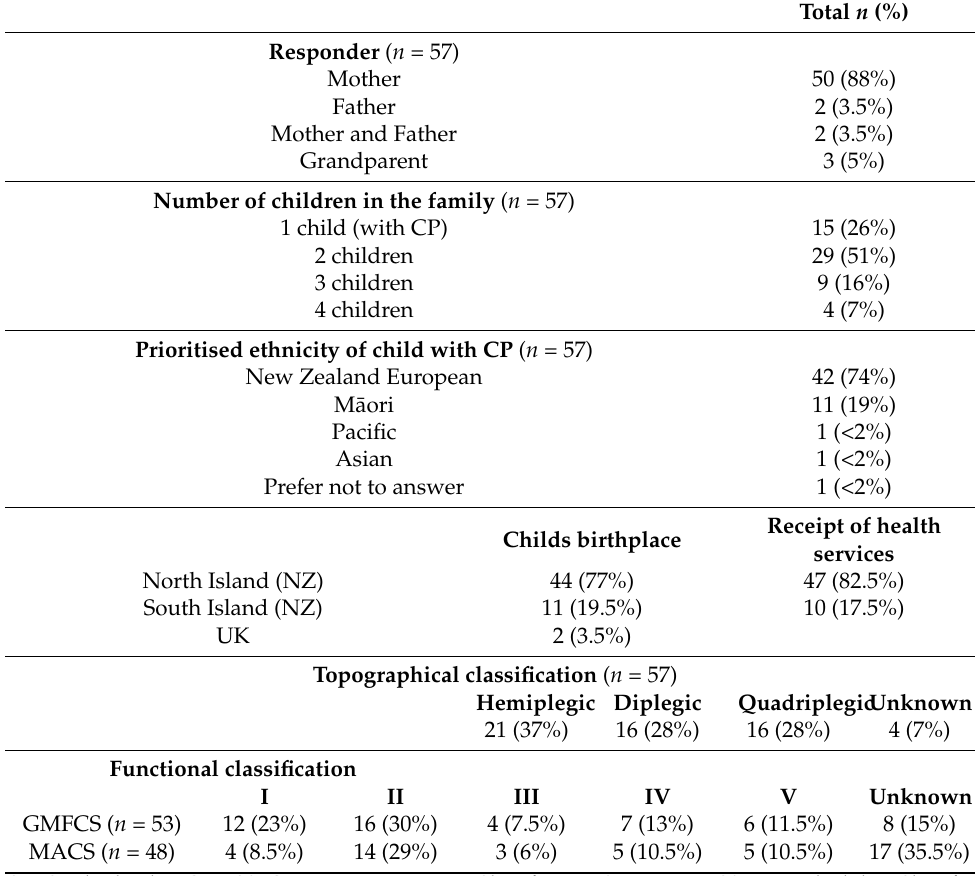
Table 1. Family and child